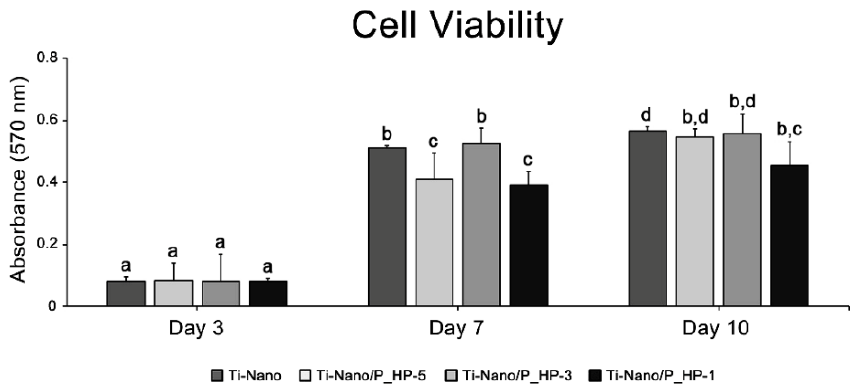
Figure 6. Cell viability (MTT assay, optical density) on days 3, 7, and 10 of UMR-106 cell cultures grown on Ti-Nano surfaces functionalized with 1 × 10 − 5 , 1 × 10 − 3 , 1 mg/mL grape-pomace extract and the control surface (Ti-Nano, Ti-Nano/P_HP-5, Ti-Nano/P_HP-3, and Ti-Nano/P_HP1). The bars that share the same letter are not significantly different from each other ( p >